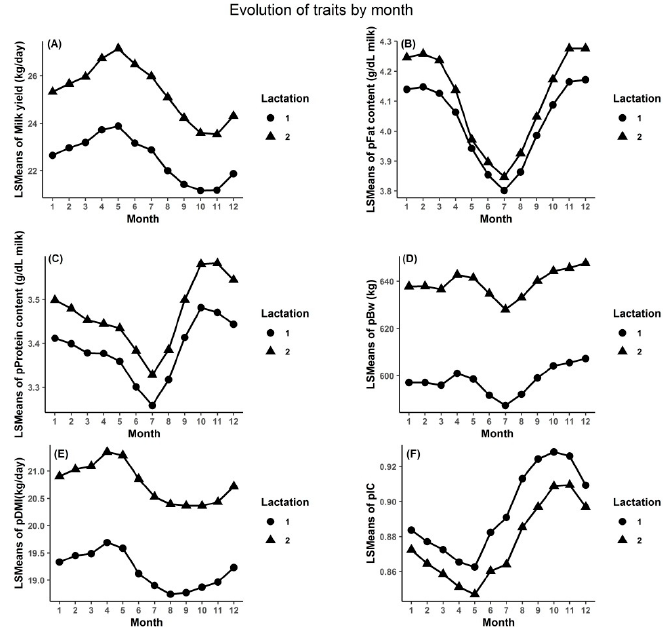
Figure 2. The evolution of the averaged herd least square means (LSMEANS) for all studied traits across test months (LSMEANS of milk yield ( A ); LSMEANS of predicted fat content ( B ); LSMEANS of predicted protein content ( C ); LSMEANS of predicted body weight ( D ); LSMEANS of predicted dry matter intake ( E ); LSMEANS of predicted consumption index ( F